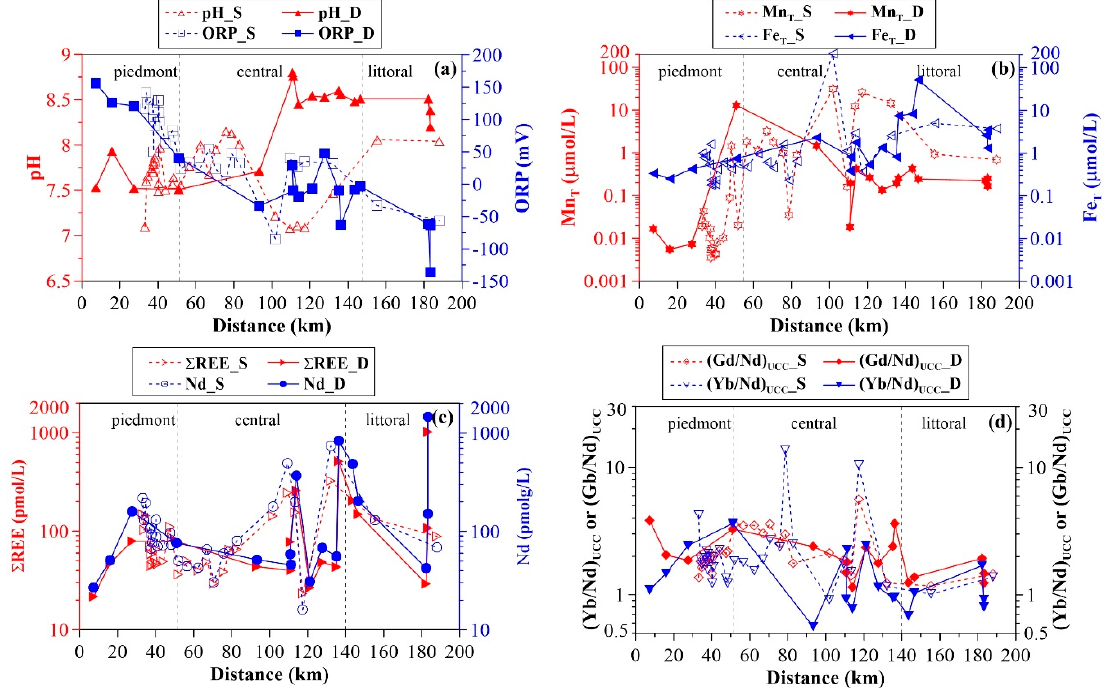
Figure 3. Groundwater parameters as a function of distance from the recharge area (( a ): pH and ORP; ( b ): total Mn (Mn T ) and total Fe (Fe T ); ( c ): total REE ( ∑ REE) and Nd; and ( d ): (Gd/Nd) UCC and (Yb/Nd) UCC ).